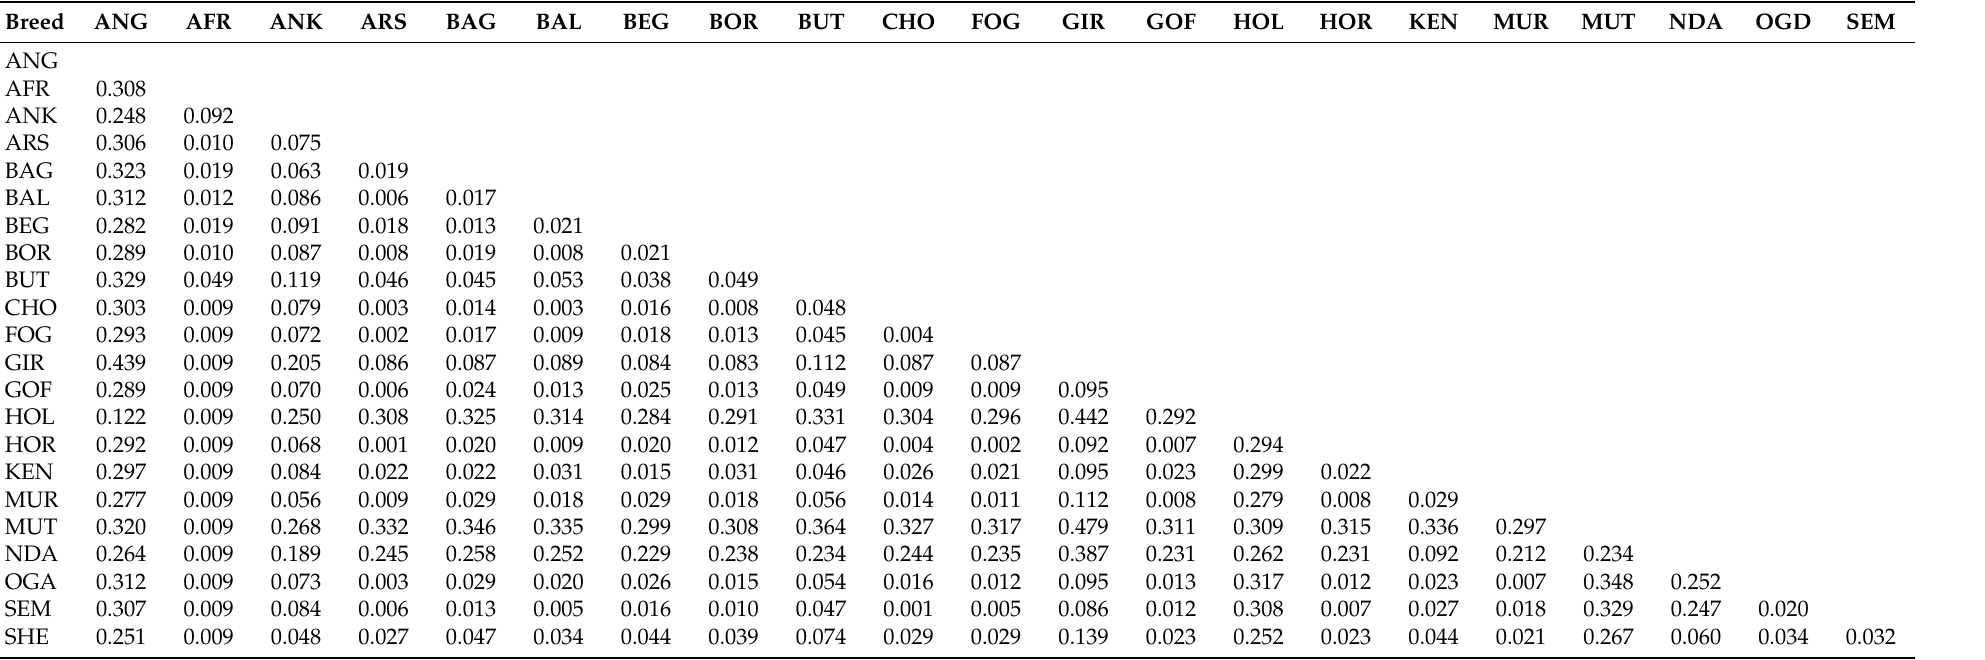
Table 3. Genetic differentiation ( F ST ) between Ethiopian and non-Ethiopian cattle